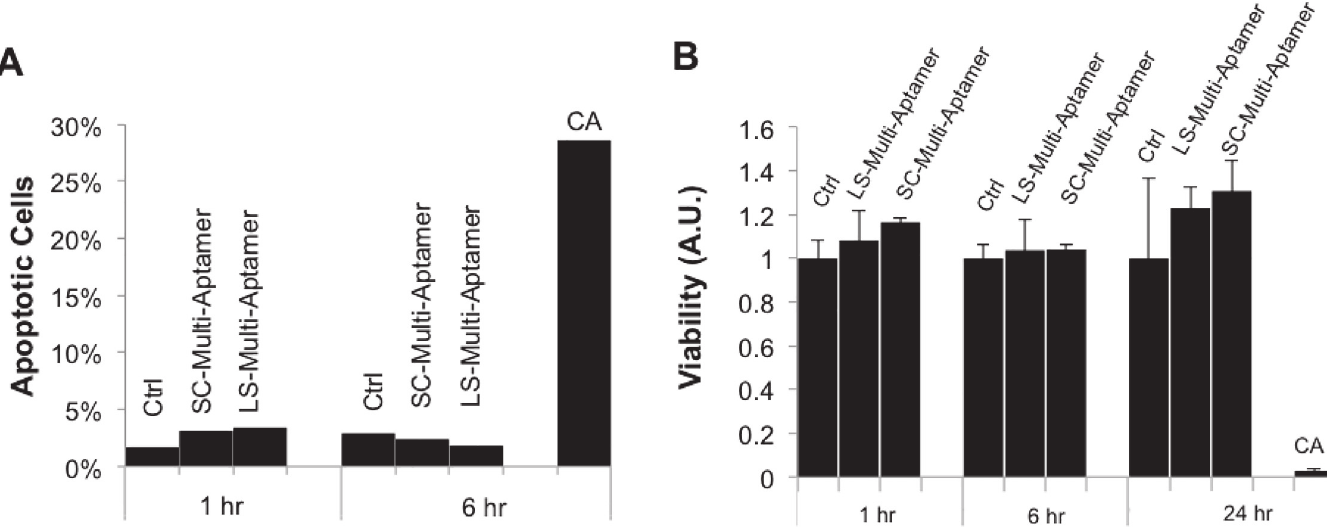
Fig 5. The Multi-Aptamer does not induce apoptosis or affect cell viability. (A) Jurkat cells were untreated or treated with SC-Multi-Aptamer, LS-Multi- Aptamer. Treatment with cyclosporine A (CA) served as a control. Apoptosis was assessed at the indicated time points by flow cytometry analysis of annexin V and propidium iodide (PI). (B) To assess potential effects on cell viability or proliferation, Jurkat cells were treated with the indicated compounds. Cell viability was assessed by introduction of XTT reagent. Treatment with 50 μ M CA served as a control. Error bars are standard error of the mean